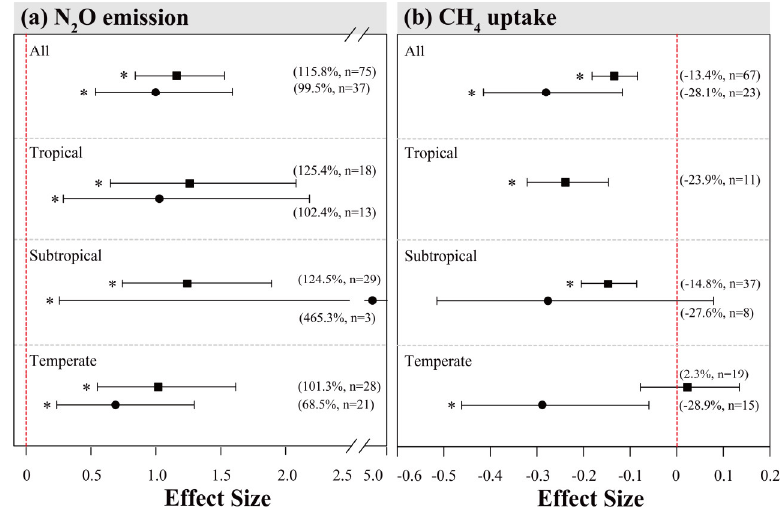
of less than 5 years.